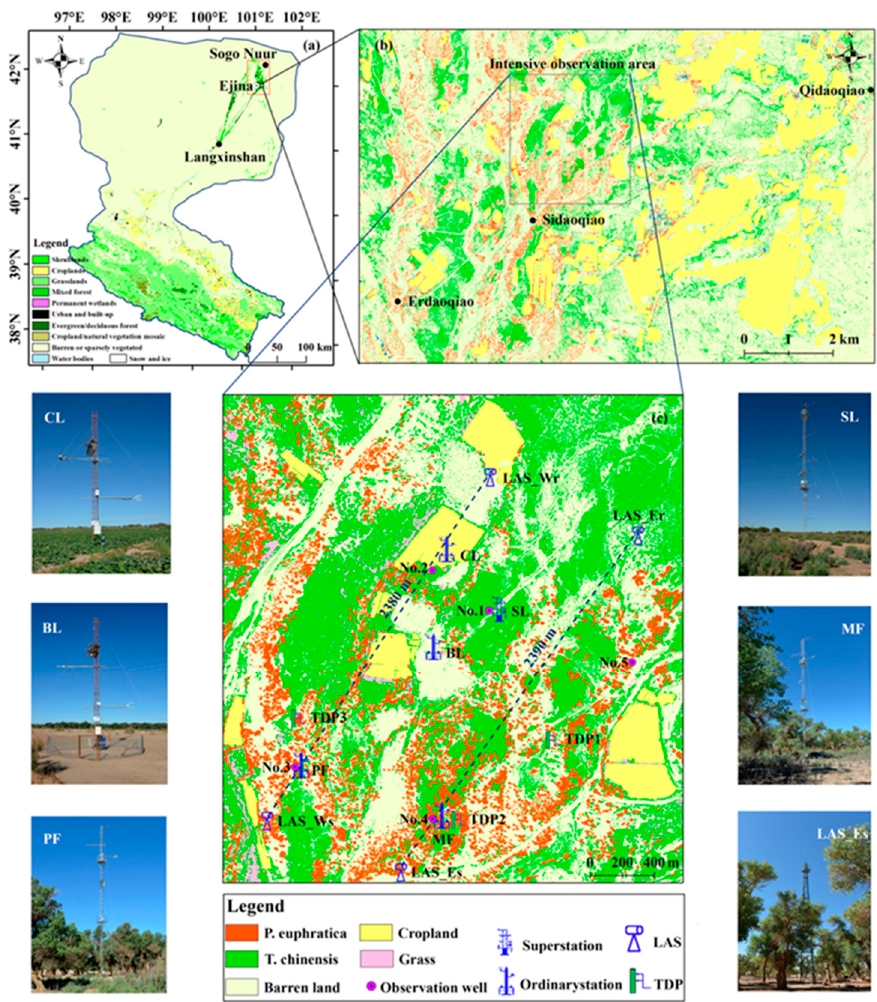
Figure 1. ( a , b ) The location of the study area and ( c ) spatial distribution of all observation sites in the intensive observation area of the HiWATER in 2014. LAS_Es and LAS_Ws indicate the locations of LAS transmitter, LAS_Er and LAS_Wr the locations of paired receiver. The field pictures of five observation sites and LAS_E transmitter were also presented in ( c ).